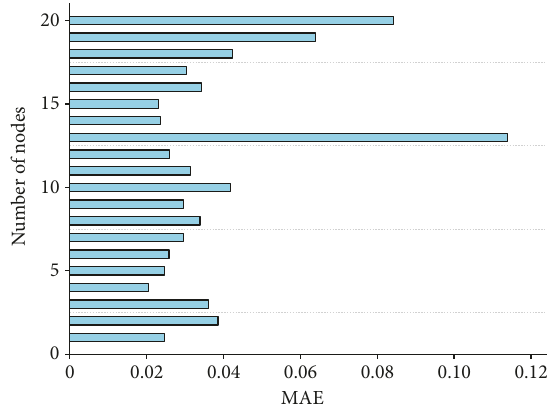
Figure 10: Neural node optimization of single-hidden layer